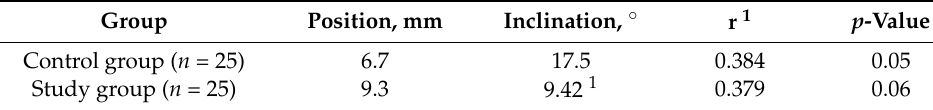
Table 5. Correlations between incisor position and forehead inclination. Group Position,